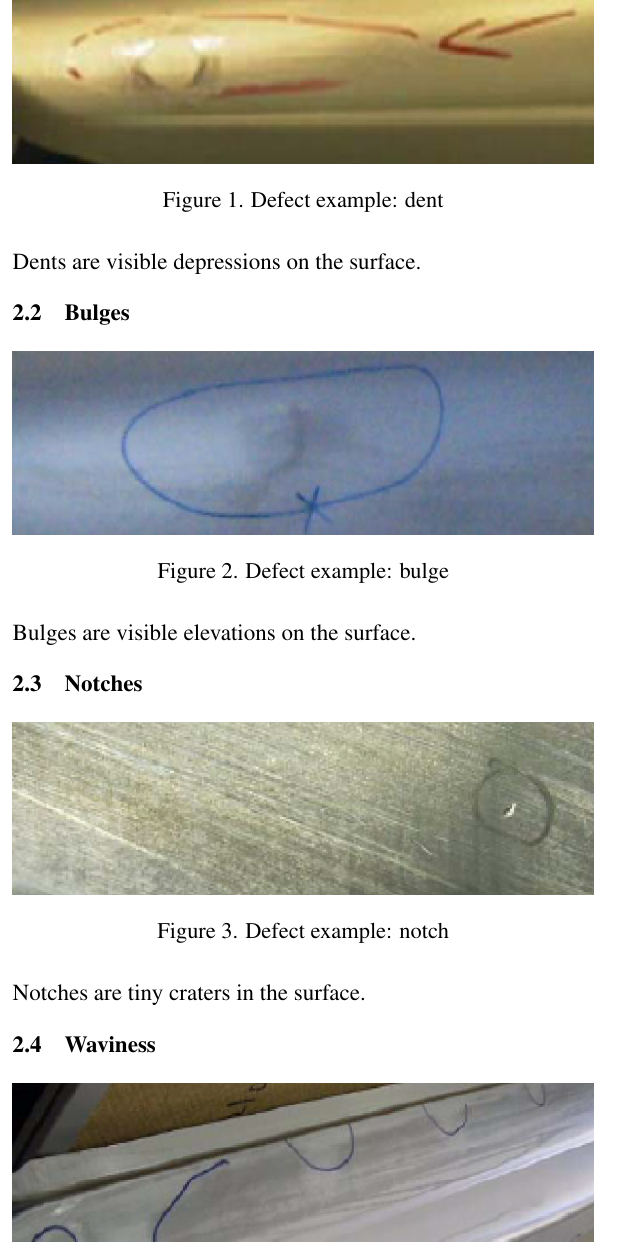
Figure 5. Defect example: pimples Pimples are clusters of high spots (dirt spots) on the surface.